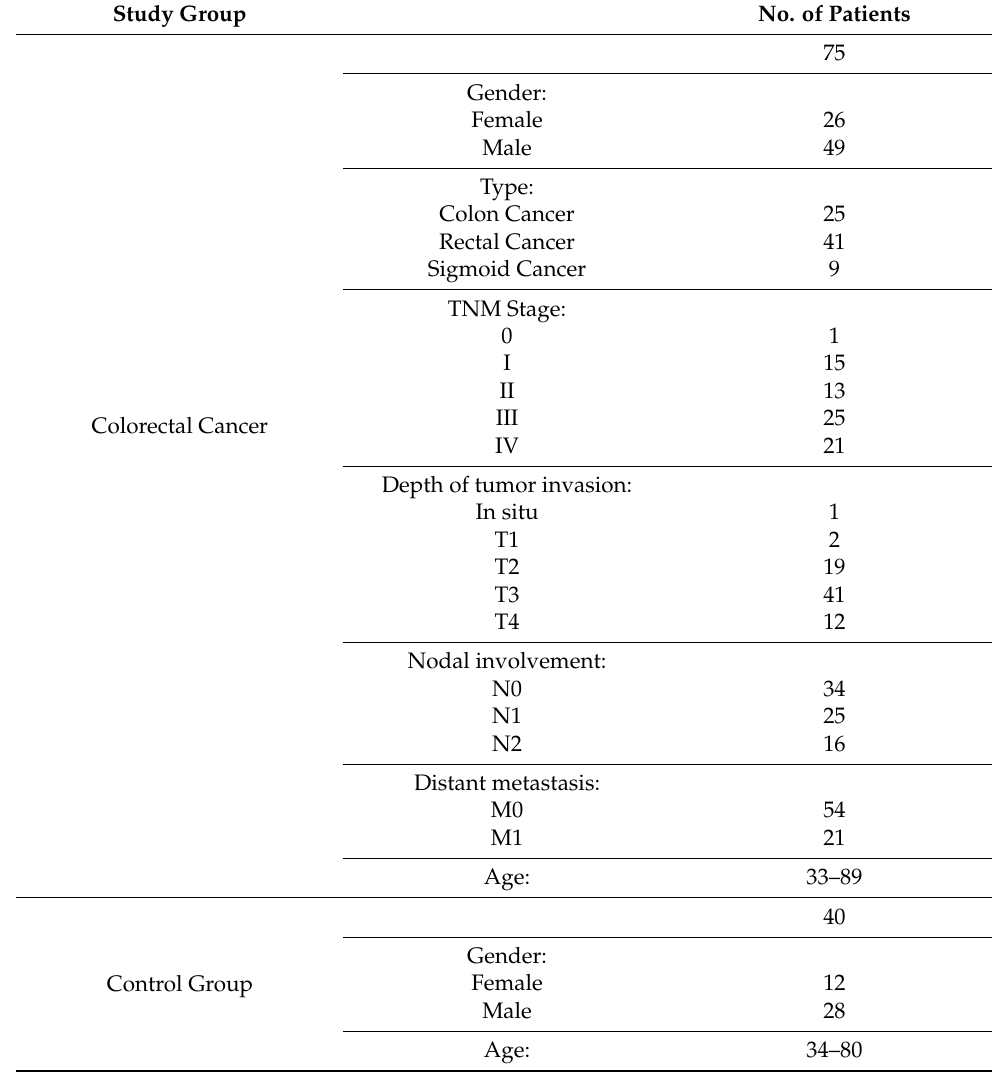
Table 1. Characteristics of colorectal cancer and healthy patient groups. Study